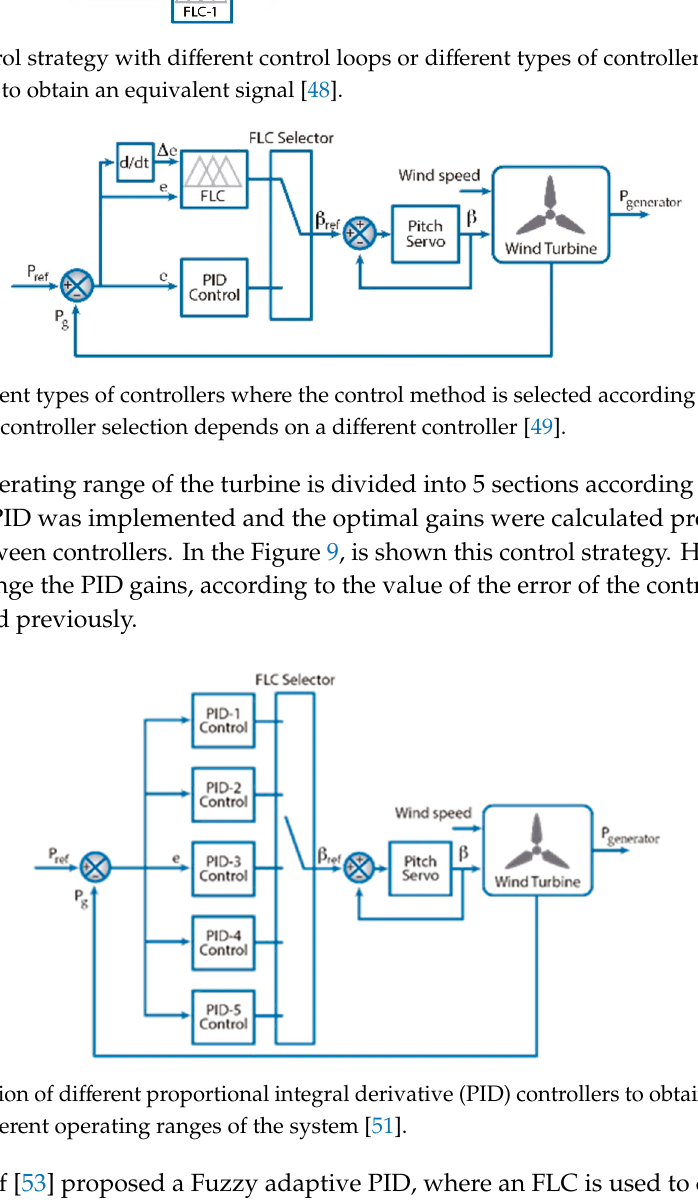
Figure 10. Adaptive control algorithm calculates the gains of a PID controller in real time; the strategy to change the values of the gains is done with FLC [52–54]. On the other hand, controllers of the hierarchical type have been proposed. In [56] two controllers are proposed, the first one is a classic fractional order PI (FOPI) controller, this controller implements an FLC to change the real-time PI gains (FFOPI). The second is a PI, the integral part is FFOPI and is added to the proportional part represented by a gain Kp (FFOPI + I). A PSO algorithm determined initial gains. In [57], the author proposes a control model (PIFPI) based on the